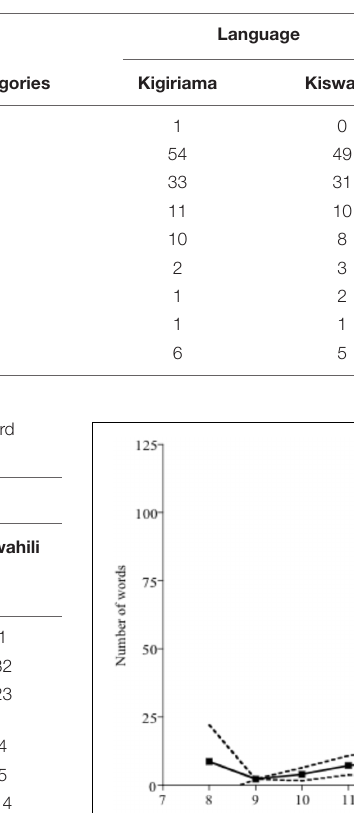
TABLE 2 | Highest ranked 50 words in each language, categorized by word class – Count of words for Production.